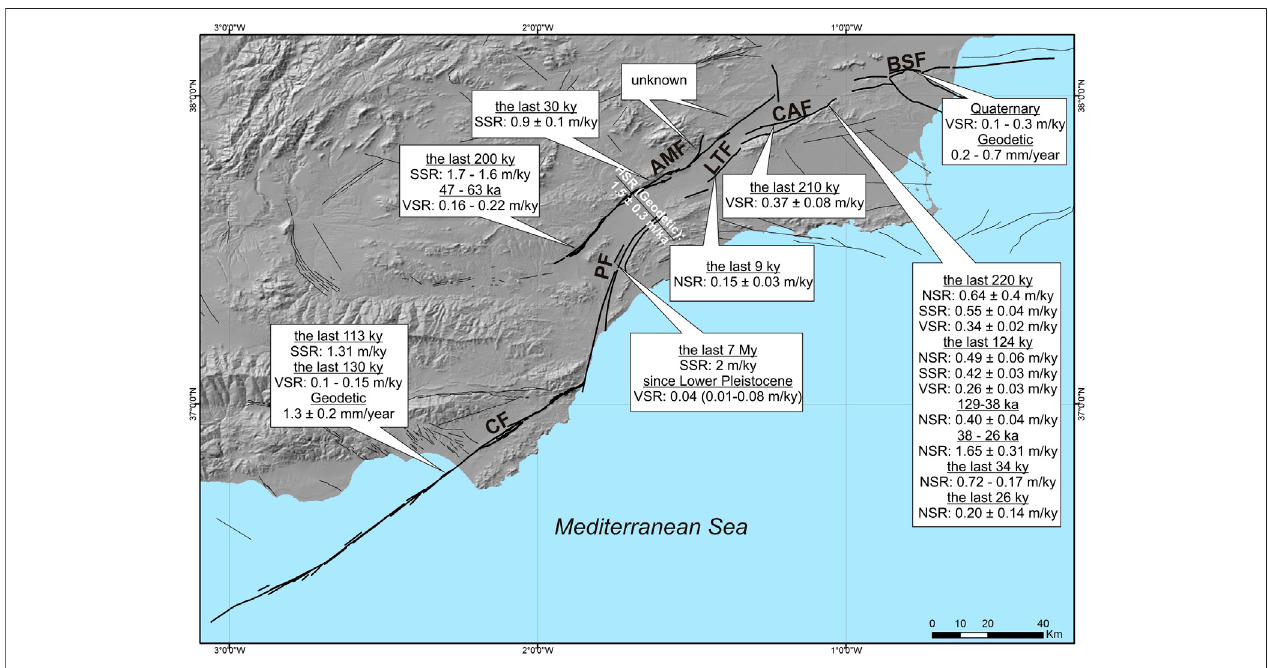
FIGURE 10 | Summary of slip rate values available for faults belonging to the Eastern Betic Shear Zone with indication of the time interval (modi fi ed from Ferrater, 2016). NSR: net slip rate. SSR: strike slip rate. VSR: vertical slip rate. CF: Carboneras Fault (Moreno, 2011; Moreno et al., 2015; Echeverría et al., 2015). PF: Palomares Fault (Weijermars, 1987; Booth-Rea et al., 2003; García-Mayordomo, 2005). AMF: Alhama de Murcia Fault (Ortuño et al., 2012; Ferrater, 2016). LTF: Los Tollos Fault (Insua-Arévalo etal.,2015).CAF:SO(Martín-Bandaetal.,2015).BSF:Bajo SeguraFault(Alfaroet al.,2012;Borqueetal . ,2019).HSR(Geodetic)blank:horizontal slip rate of the set Alhama de Murcia Fault and Palomares Fault (Echeverria et al., 2013).